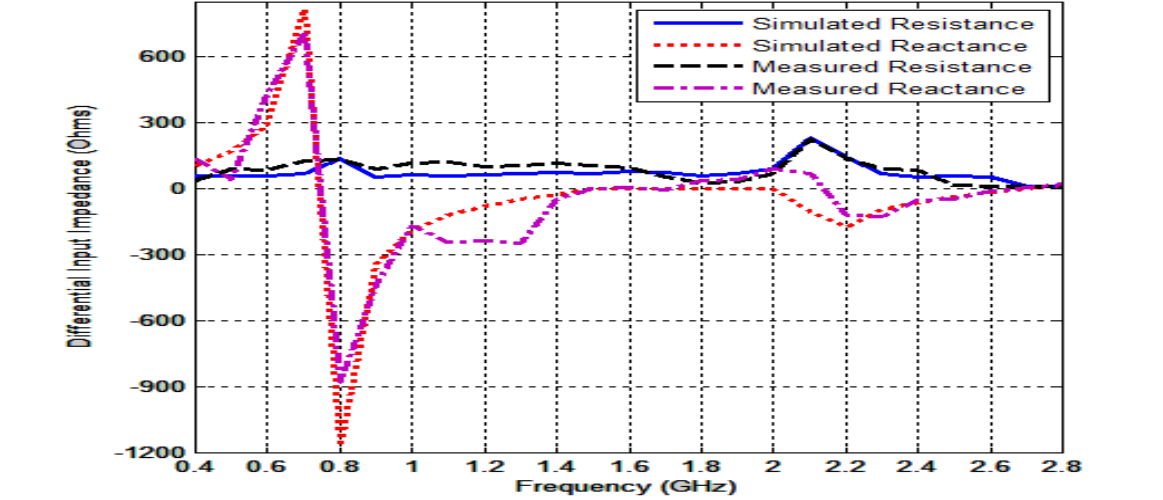
Figure 5. The simulated and measured differential input